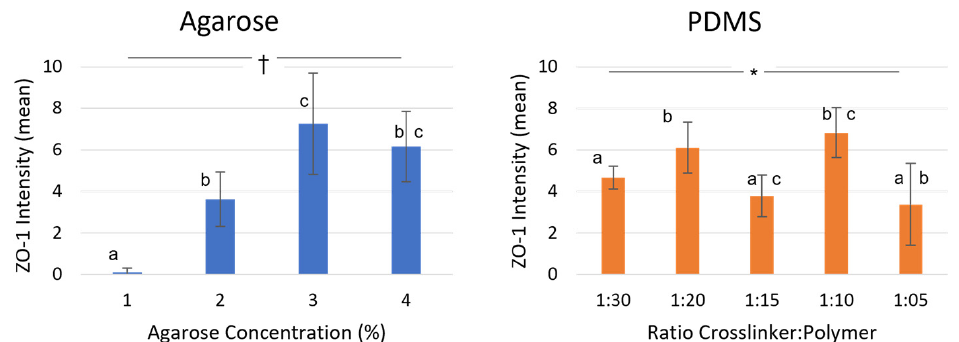
Figure 7. ( Left ) The diagram represents the measured mean intensity ( n = 5) of the stained tubes